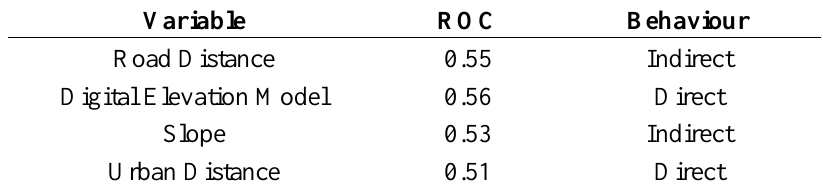
Table 3. Logistic regression model of the centroid points of paramo burned areas and the predictive variables road distance, altitude, slope gradient and urban